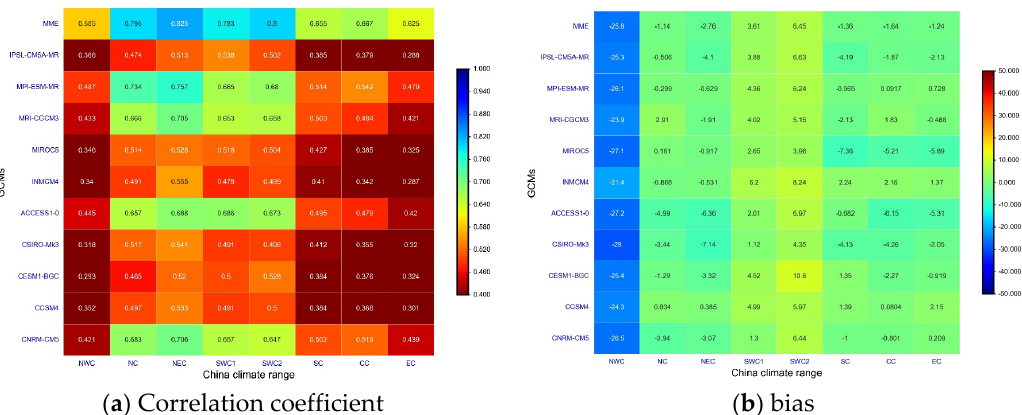
Figure 3. Correlation coefficient ( a ) and bias (unit: %) ( b ) between ITPCAS monthly precipitation and simulations from the CMIP5 model as well as MME over eight climate regions from 1979–2000.